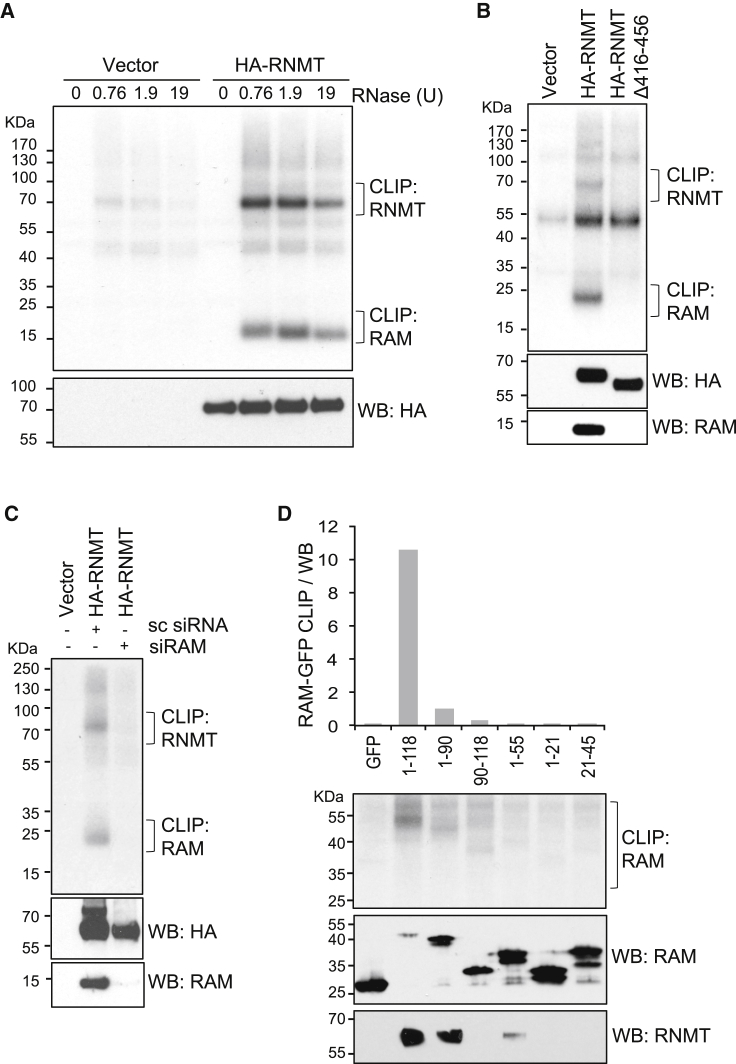
RAM Is Required for RNMT-RNA Interaction(A) Anti-HA antibody CLIP (crosslinking IP) performed on HeLa cells expressing HA-RNMT or control. IP was performed with or without prior incubation with RNase titration. 32P-labeled transcripts were visualized by autoradiography (0.38 U RNase was used in subsequent assays).(B) Anti-HA antibody CLIP performed on HeLa cells expressing HA-RNMT WT, Δ416–Δ456, and vector control.(C) mESC expressing HA-RNMT transfected for 72 hr with RAM siRNA or non-targeting control. Anti-HA antibody CLIP was performed.(D) Anti-GFP CLIP performed on HeLa cells transfected with pcDNA5 GFP and GFP-RAM constructs. Quantification of the RAM CLIP signal was normalized to the RAM western blot signal.CLIPs and western blots were performed on the same membrane.